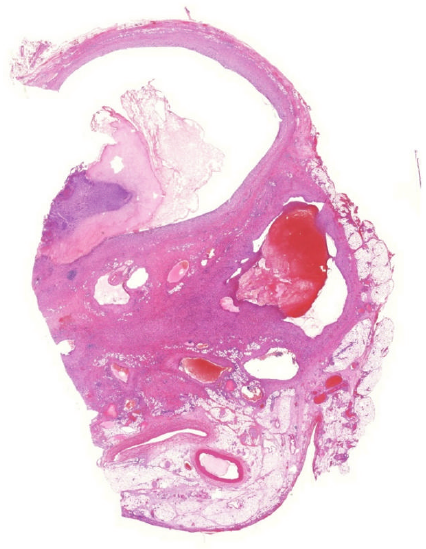
Figure 3: Histological image shows multiple smaller cysts spread out through the mesenteric fat. These represent areas of fat necrosis, which favor the diagnosis of a false cyst. Hematoxylin and eosin stain, ×